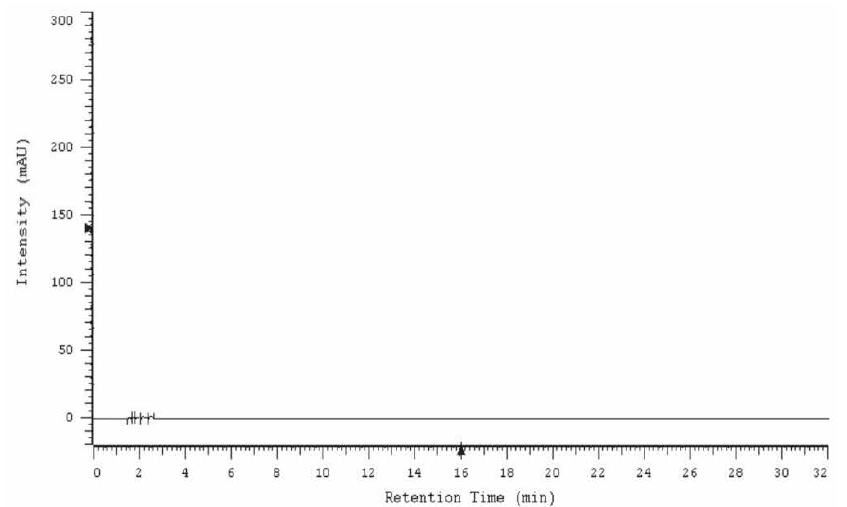
FIGURE 2 – Chromatogram of drug-free perfusion solution. Determination using UV detector set at a wavelength of 270 nm (see Instrumentation and chromatographic conditions section for details regarding chromatographic condition).